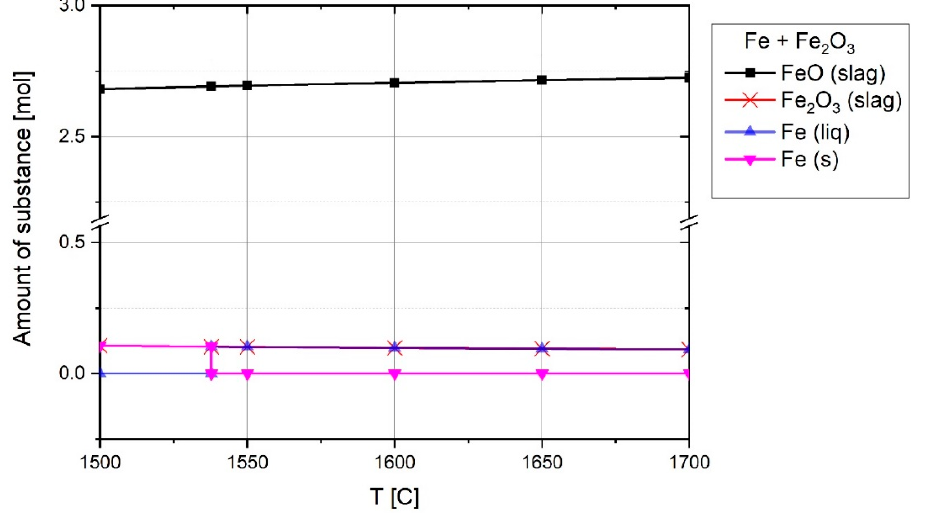
Figure 8. Chemical composition of 1 mol Fe and 1 mol of Fe 2 O 3 at equilibrium at 1 atm pressure above melting temperature, FactSage TM 7.2 (Database: FactPS and FToxide (2018)).